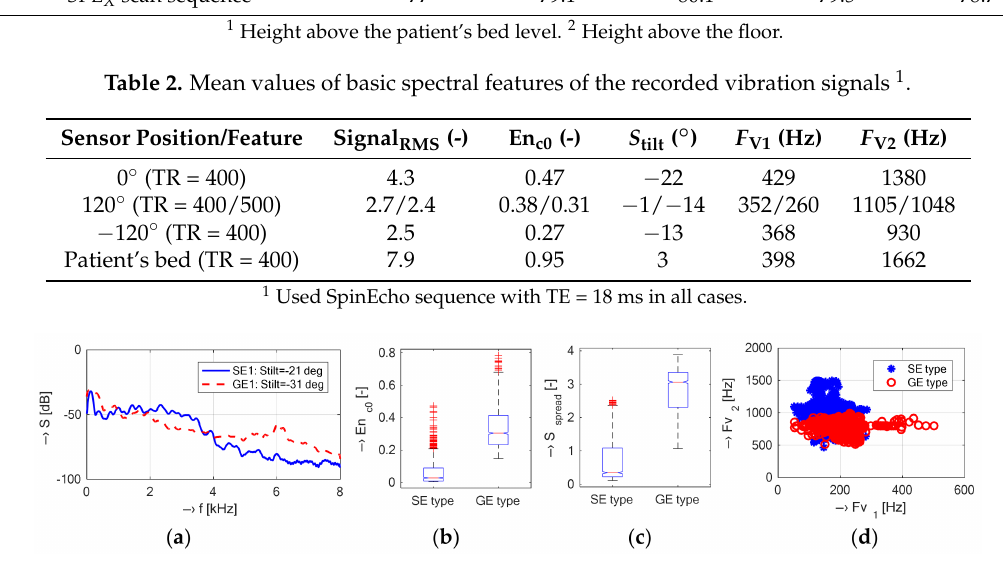
Figure 5. Visualization of differences of selected features of the recorded vibration signals; ( a ) spectral envelopes and calculated spectral tilts; ( b ) boxplot of basic statistical properties for En c0 ; ( c ) S spread ; ( d ) mutual positions of F v1 and F v2 for SE/GE scan sequences with TE = 18 ms and TR = 500 ms.